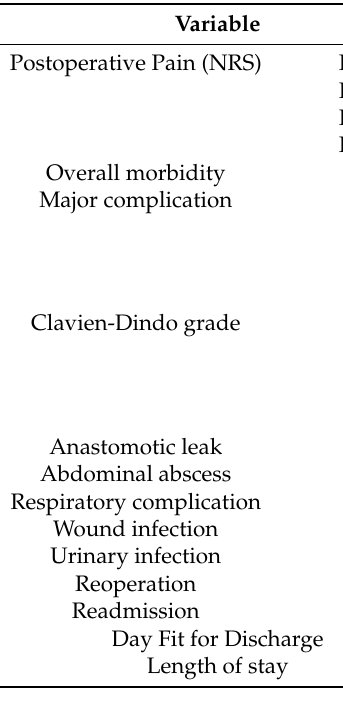
Table 4. Patient’s outcomes.